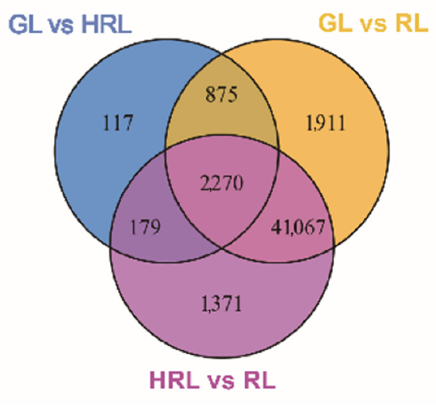
Figure 5. Venn diagram of DEGs in each comparison group: green versus orange (GL vs. HRL), green versus red (GL vs. RL), and orange versus red leaves (HRL vs. RL).